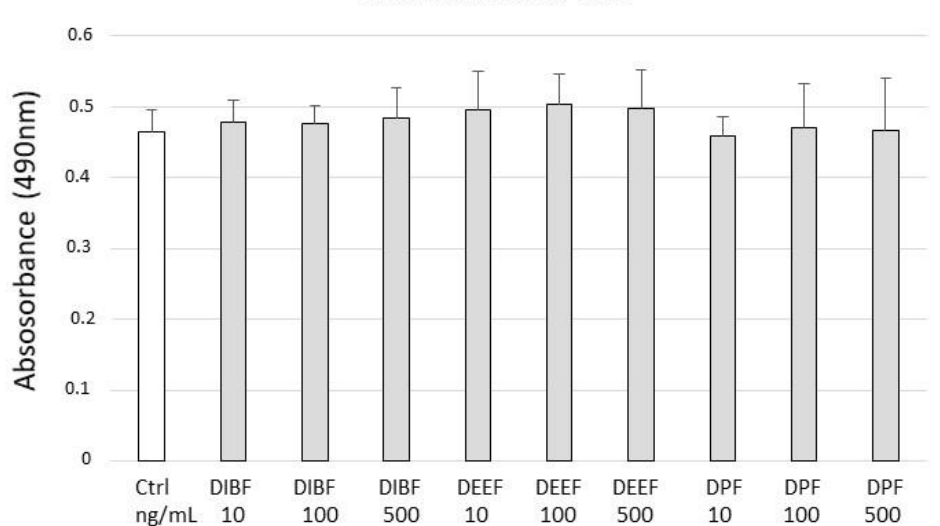
Figure 3. Caco-2 cells treated for 24 h with DIBF, DEEF, and DPF in exponential growth phase, proliferating (at day 3 after seeding). No significant changes in cell viability were observed. The evaluation was performed by MTS assay, as an indirect measure of mitochondrial metabolic capac- ity.